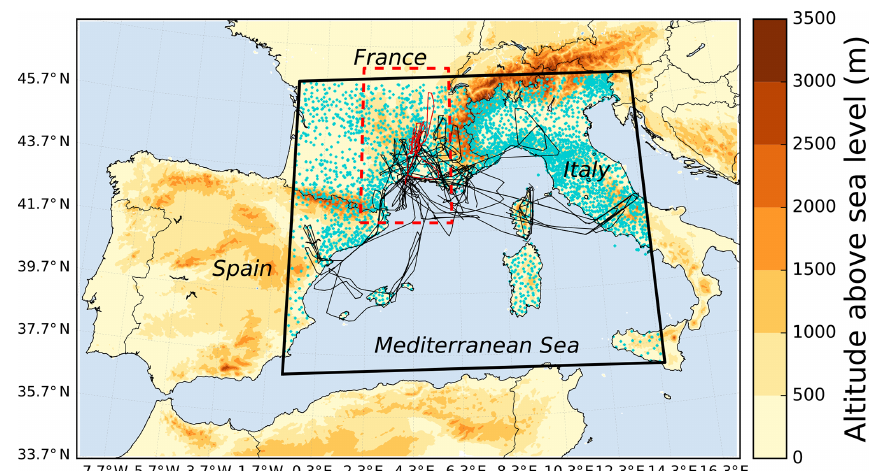
Figure 1. The Falcon 20 flight tracks (black lines) during the HyMeX first special observing period over the AROME-WMed domain. The Falcon 20 flight track during IOP7a (flight 15) is indicated by the red line. IOP7a case study is delimited by the red box. The altitude of ground above sea level (in metres) is represented by the colour shades. The rain gauges are represented by the blue markers. The black box shows the domain used for the impact study in Sect.